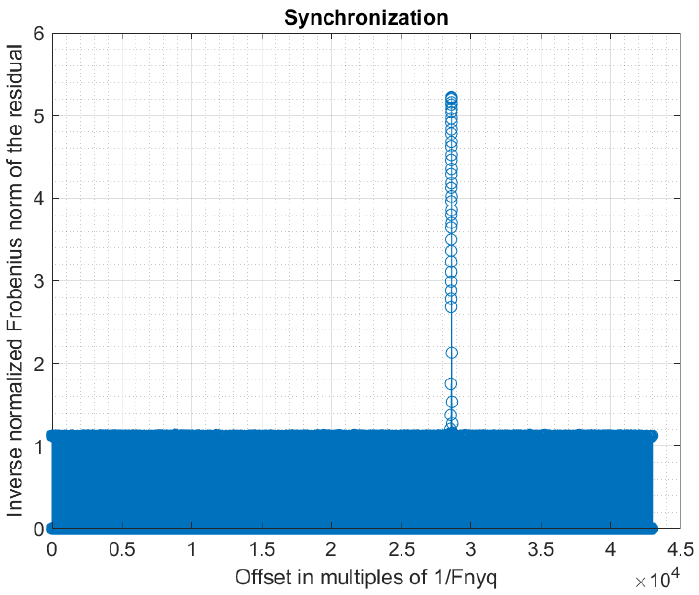
Figure 12. Synchronization